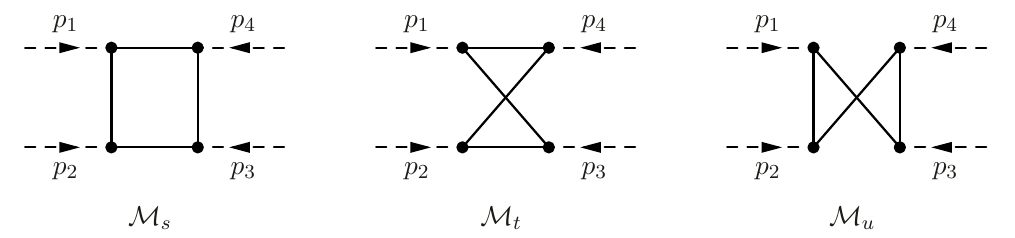
Figure 4 . The 3 connected Feynman diagrams that contribute to the 4-point function of the operator φ 2 in the free scalar theory. The dashed lines indicate the external operator O ∼ the solid lines represent propagators of the free field φ